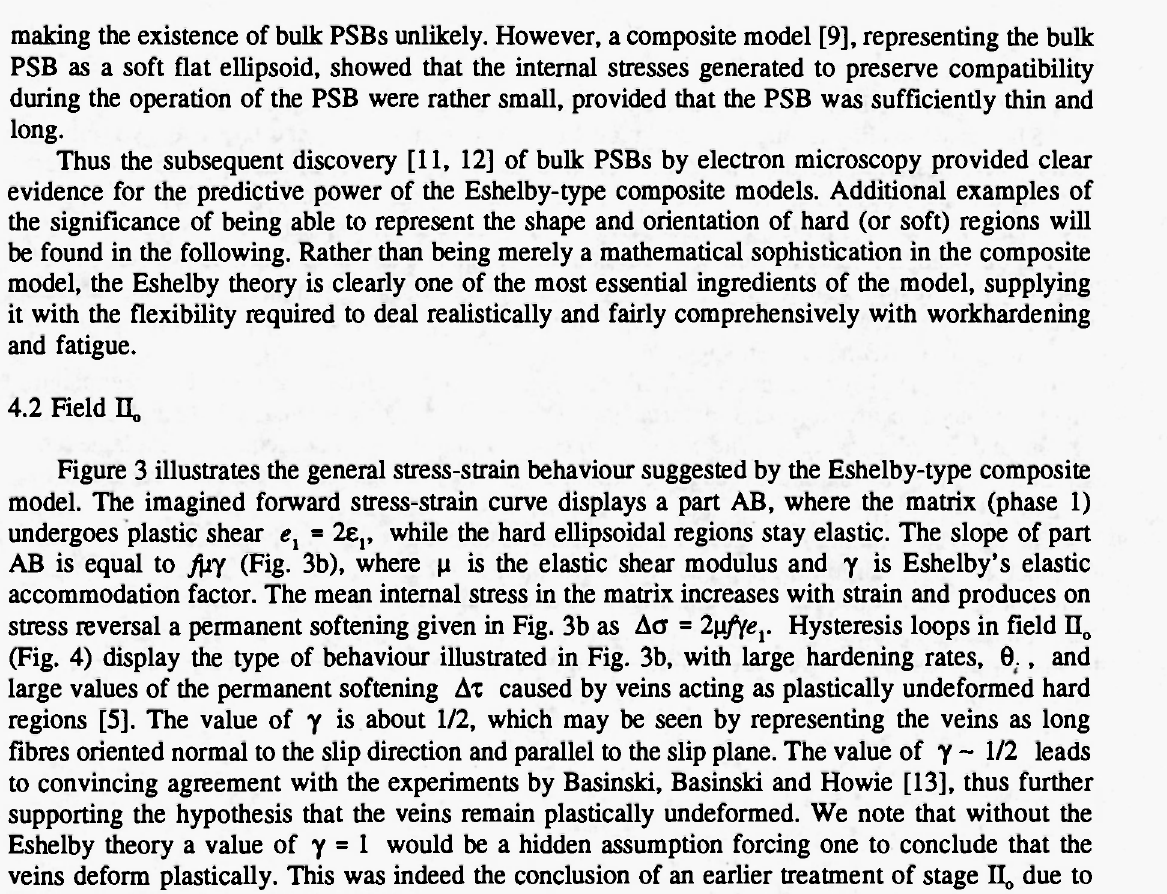
Fig. 4. Typical hysteresis loop in the low-amplitude high-cycle part of field Π 0